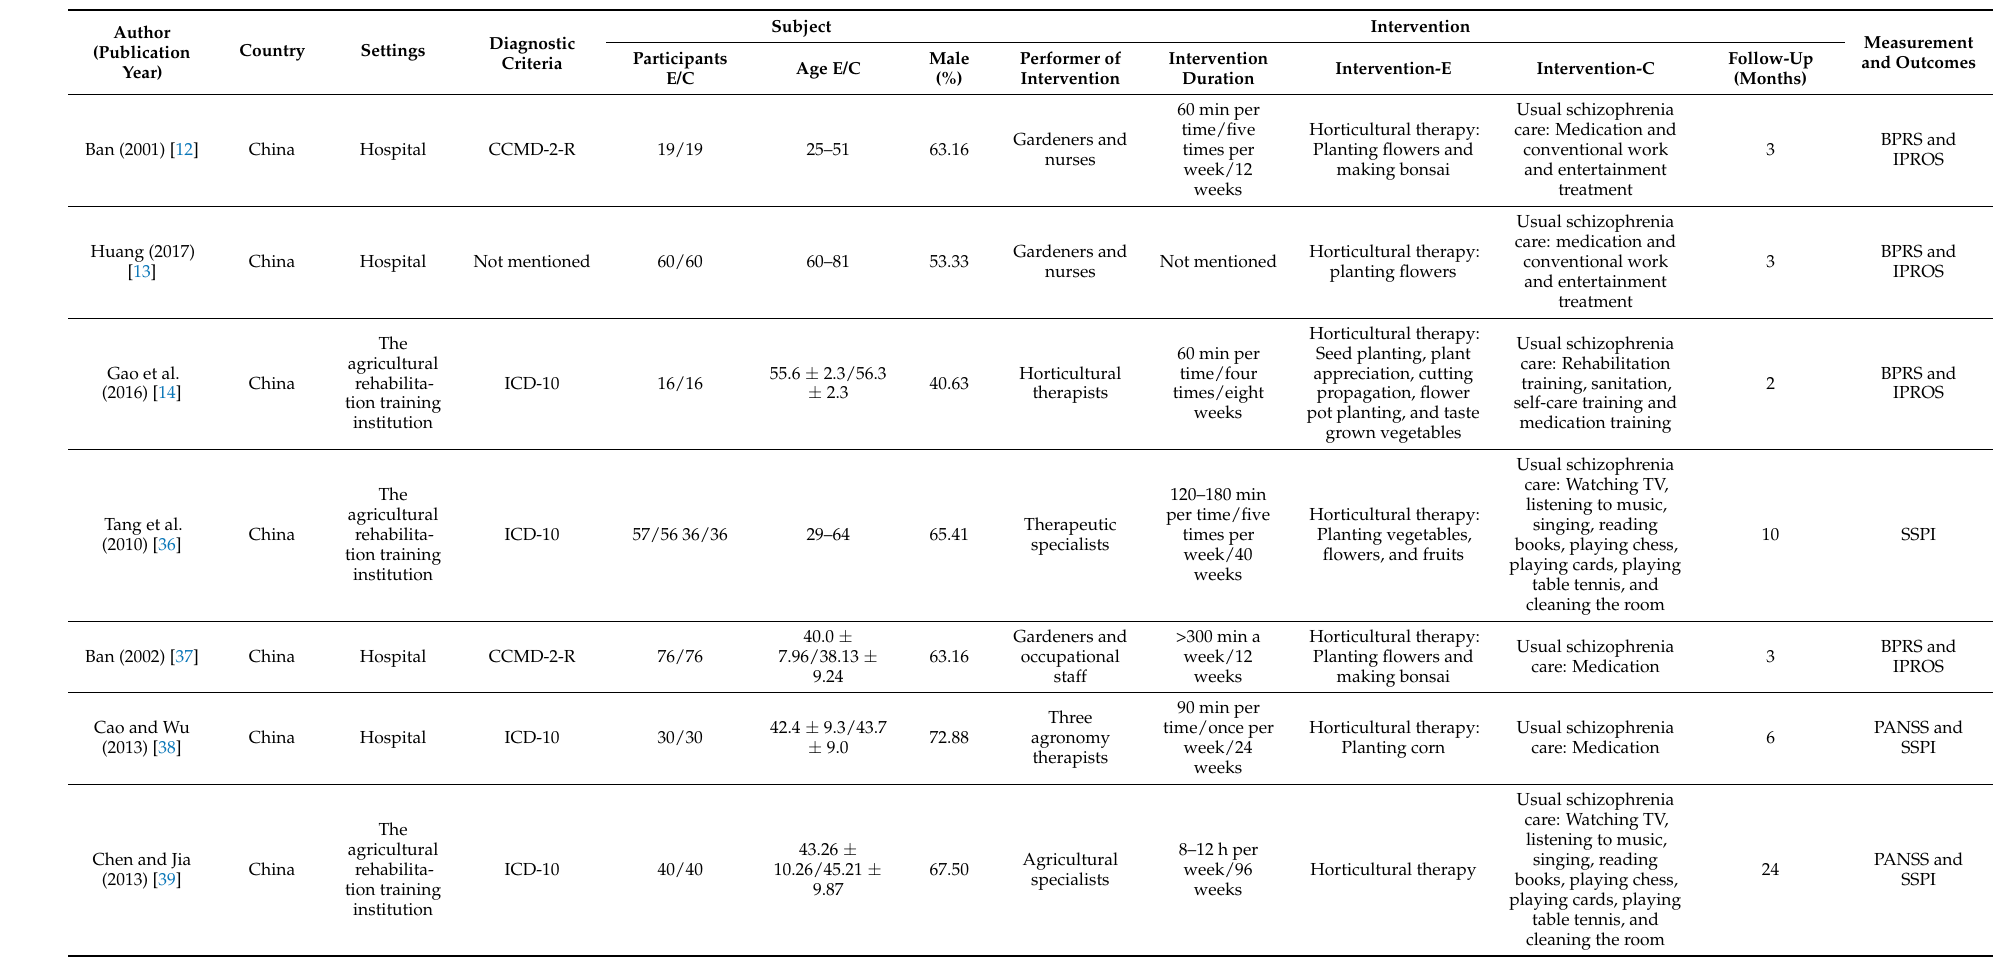
Table 2. Main characteristics of the selected